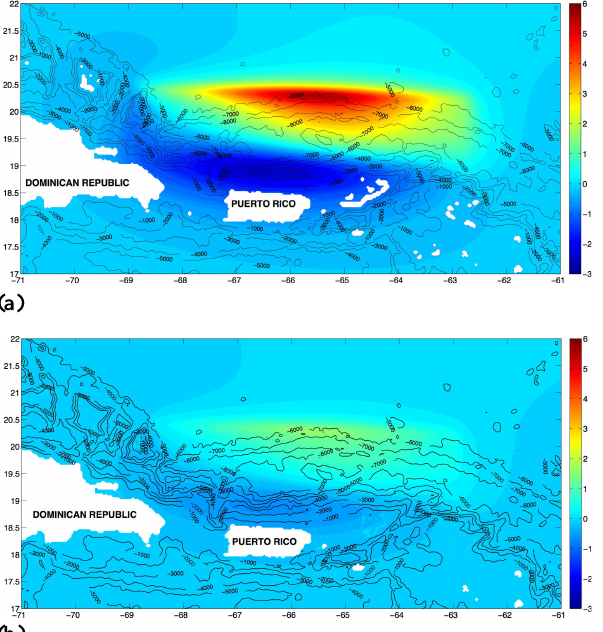
Fig. 2. ETOPO-2 bathymetry (black isobaths are marked in me- ters) and tsunami source elevation (color scale in meters) for M w = (a) 9.1 and (b) 8.7, magnitude co-seismic sources, calculated using Okada’s method as initial condition for FUNWAVE, on a 2 0 × 2 0 grid (axes are in degrees of N Lat. and W Long.).